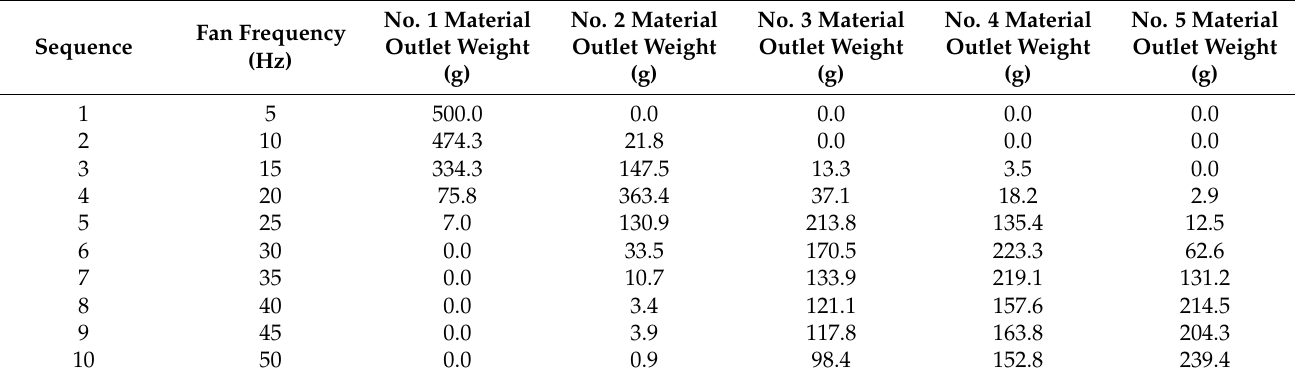
Figure 17. Relationship between fan frequency and fan speed. Table 6. Test results of single-layer tea winnowing machine for Lan tea